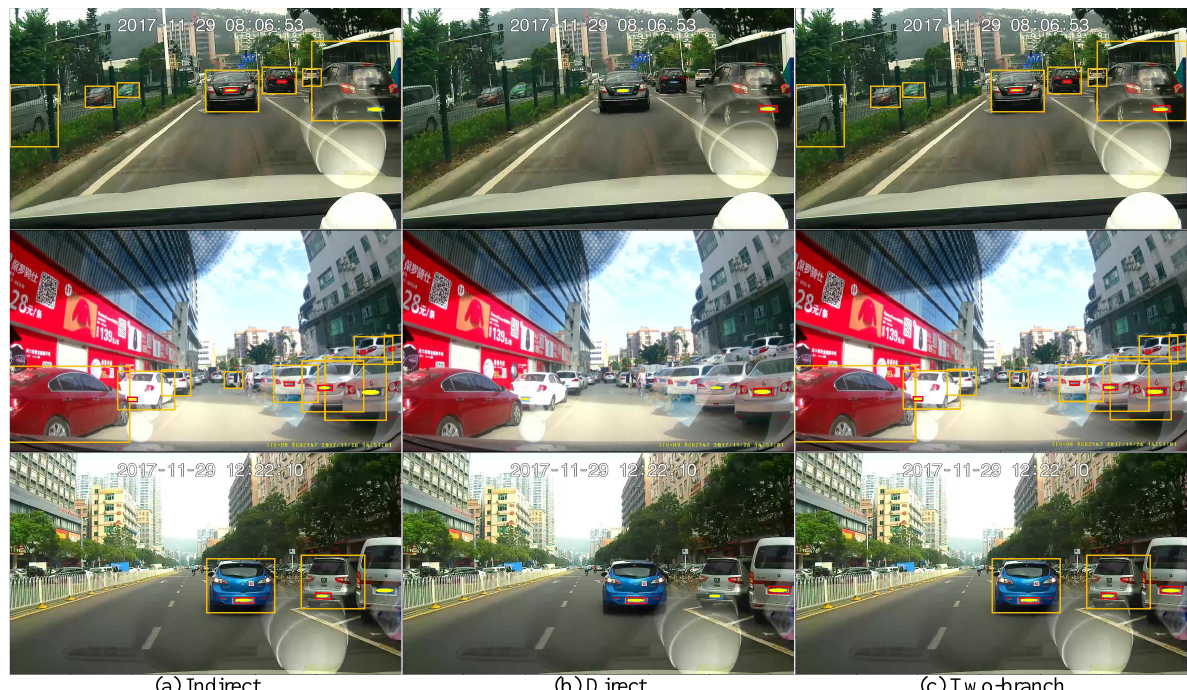
Figure 9. Detection results. The orange rectangle represents the horizontal bounding box of the vehicle. The red quadrangle indicates the quadrilateral bounding box of the license plate. Our method merges the detection results of the indirect and direct detection branches. All the recognizable license plates are manually covered with a yellow ellipsoid to protect